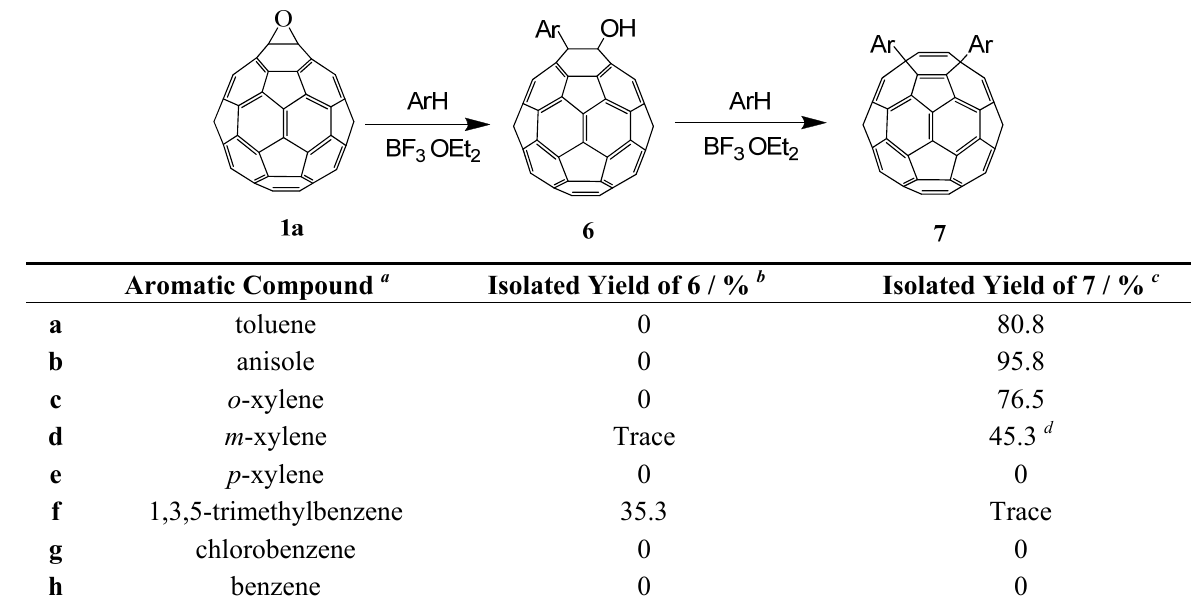
Table 4. Substitution of 1 with aromatic